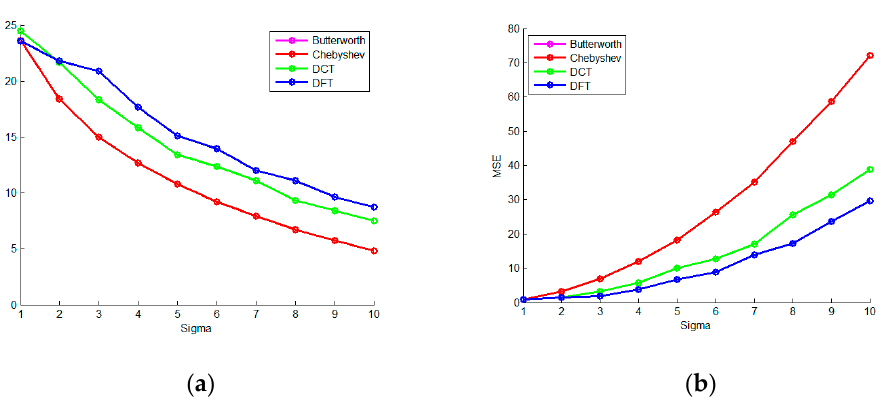
Figure 7. The Experiment on Intensity Change of Noise ( a ) is the SNR curve of four denoising methods when the sigma changes from 1 to 10, and ( b ) is the MSE curve of four denoising methods when the sigma changes from 1 to 10.